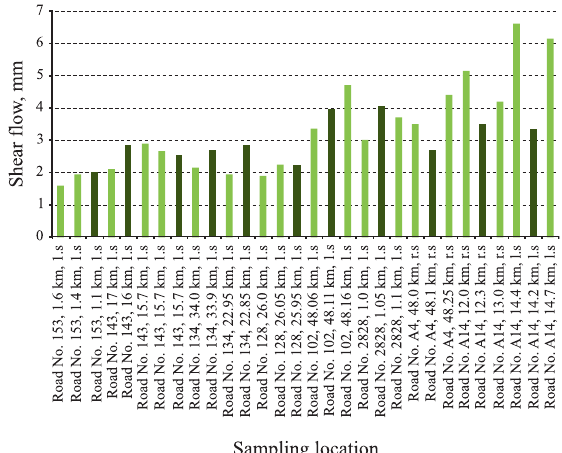
Fig. 6. Distribution of the shear flow between the upper and lower asphalt layers depending on the sampling